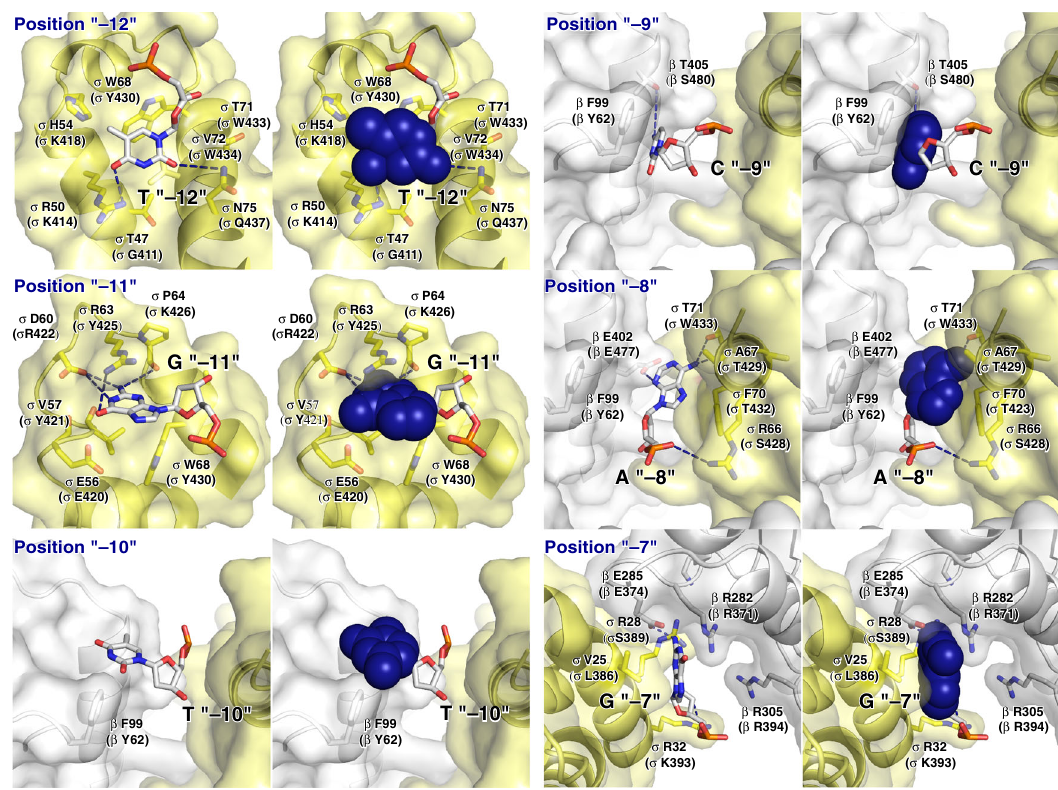
Fig. 5 Recognition by Mtb σ L of σ L -promoter -10 element: interactions with nontemplate strand positions “ -12 ” through “ -7 ” . For each promoter position, left subpanel shows DNA nucleotides in stick representation to highlight individual protein-nucleotide interactions, and right subpanel shows DNA nucleotide base moieties in space- fi lling representation to highlight protein-base steric complementarity. Yellow surfaces, solvent-accessible surfaces of Mtb σ L σ R2; gray surfaces, solvent-accessible surfaces of Mtb RNAP β subunit; dark blue surfaces, van der Waals surfaces of bases of σ L -promoter -10 element; yellow ribbons, Mtb σ L σ R2 backbone; gray ribbons, Mtb RNAP β subunit backbone; yellow, yellow-blue, and yellow-red stick representations, σ L carbon, nitrogen, and oxygen atoms, respectively; white, blue, red, and orange stick representations, DNA carbon, nitrogen, oxygen, and phosphorous atoms, respectively; blue dashed lines, H-bonds. Residues are numbered as in Mtb RNAP and σ L , and, in parentheses, as in E. coli RNAP and σ 70 . See Supplementary Fig.